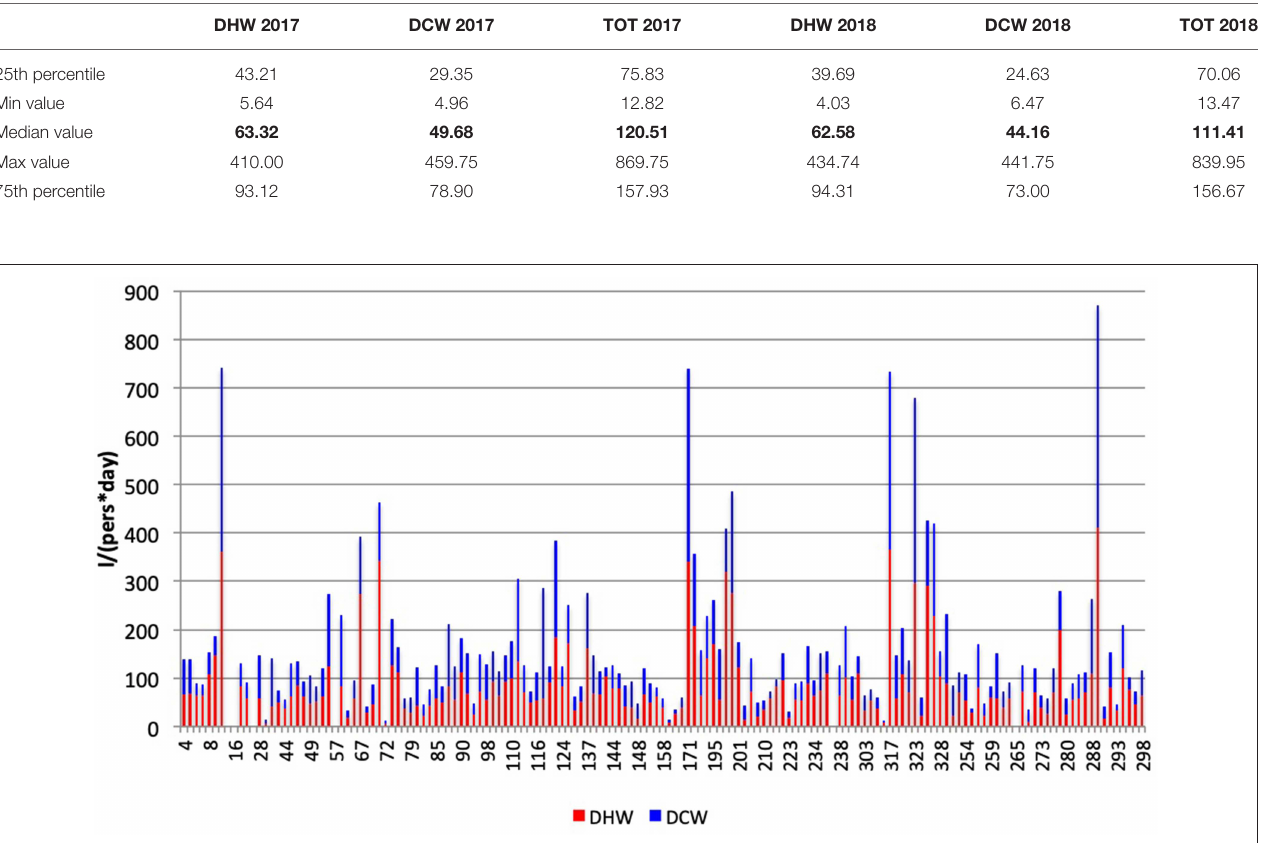
FIGURE 8 | DHW and DCW consumption in the period 2016 October 15th to 2017 October 14th of all the analyzed